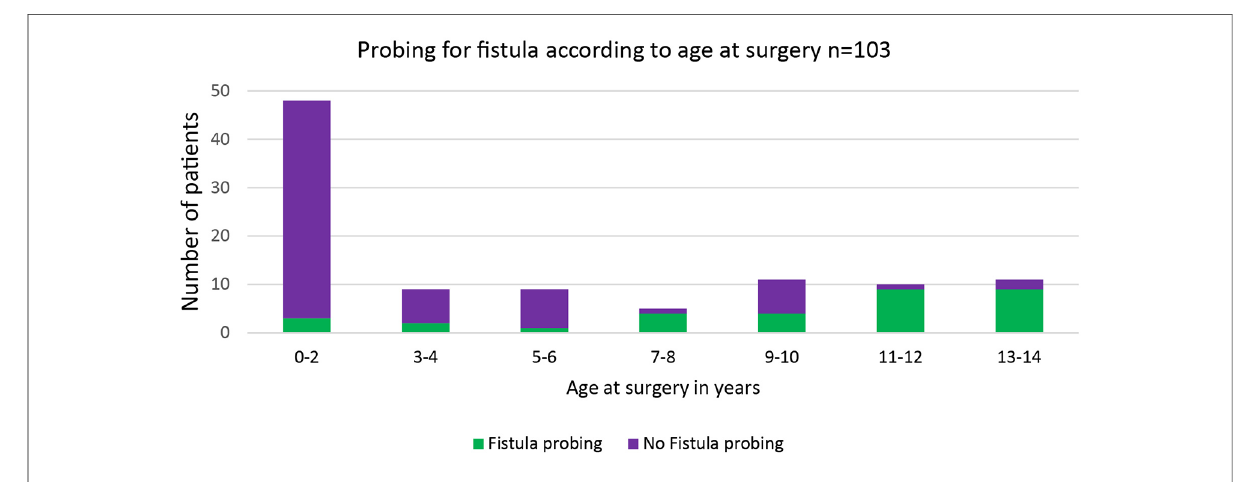
FIGURE 5 Execution of fi stula probing relative to age at the time of